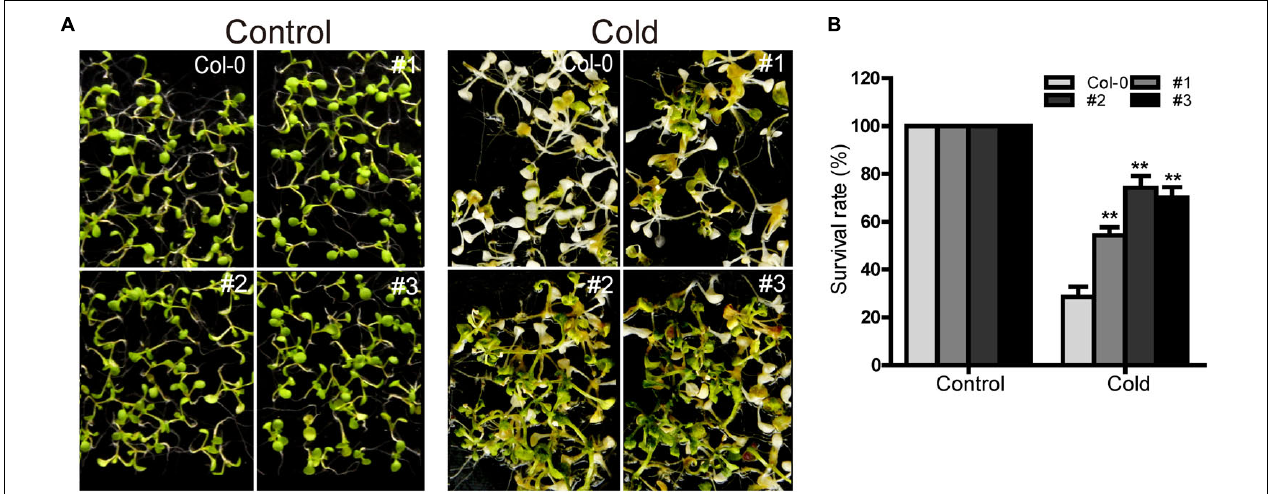
FIGURE 13 | Ectopic expression of TaDEAD-box57-3B increased cold tolerance in transgenic Arabidopsis . (A) Phenotypes of WT and TaDEAD-box57-3B transgenic plants under cold stress. (B) Survival rates of WT and TaDEAD-box57-3B transgenic lines under cold stress. Five-day-old seedlings were placed at 4 ◦ C for 1 d, –8 ◦ C for 1 h, 4 ◦ C for 12 h and then resumed at 22 ◦ C. The data are shown as the means ± SD obtained from three biological replicates. ANOVA test was used to analyze significant differences (** p <